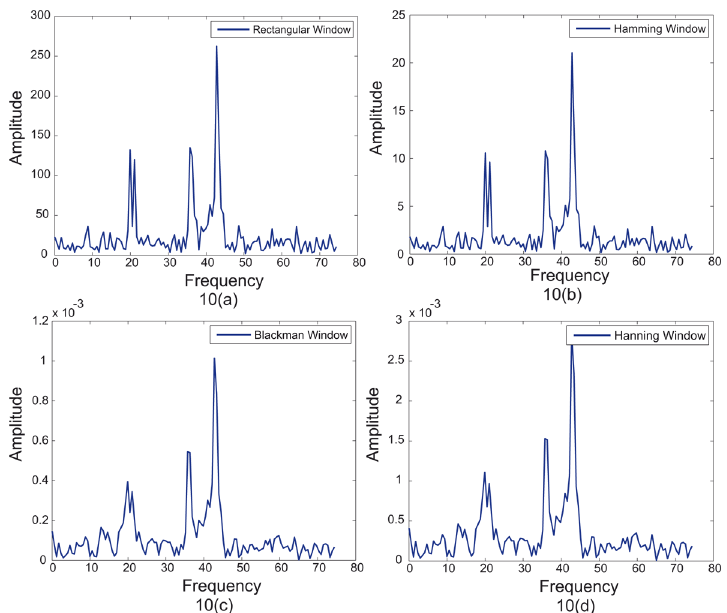
Figure 10. Effect of windowing on a signal containing nearby interfering frequency component (cultural noise). (a) Effect of Rectangular win- dow on the signal with frequency components 43 Hz, 36 Hz, 20 Hz which interact with random noise of frequency 21 Hz. (b) Effect of Ham- ming window on the same data set. (c) Effect of Blackman window on the same data set. (d) Effect of Hanning window on the same data set. Rectangular and Hamming windows have more frequency resolution between the signal frequency component of 20 Hz and noise of 21